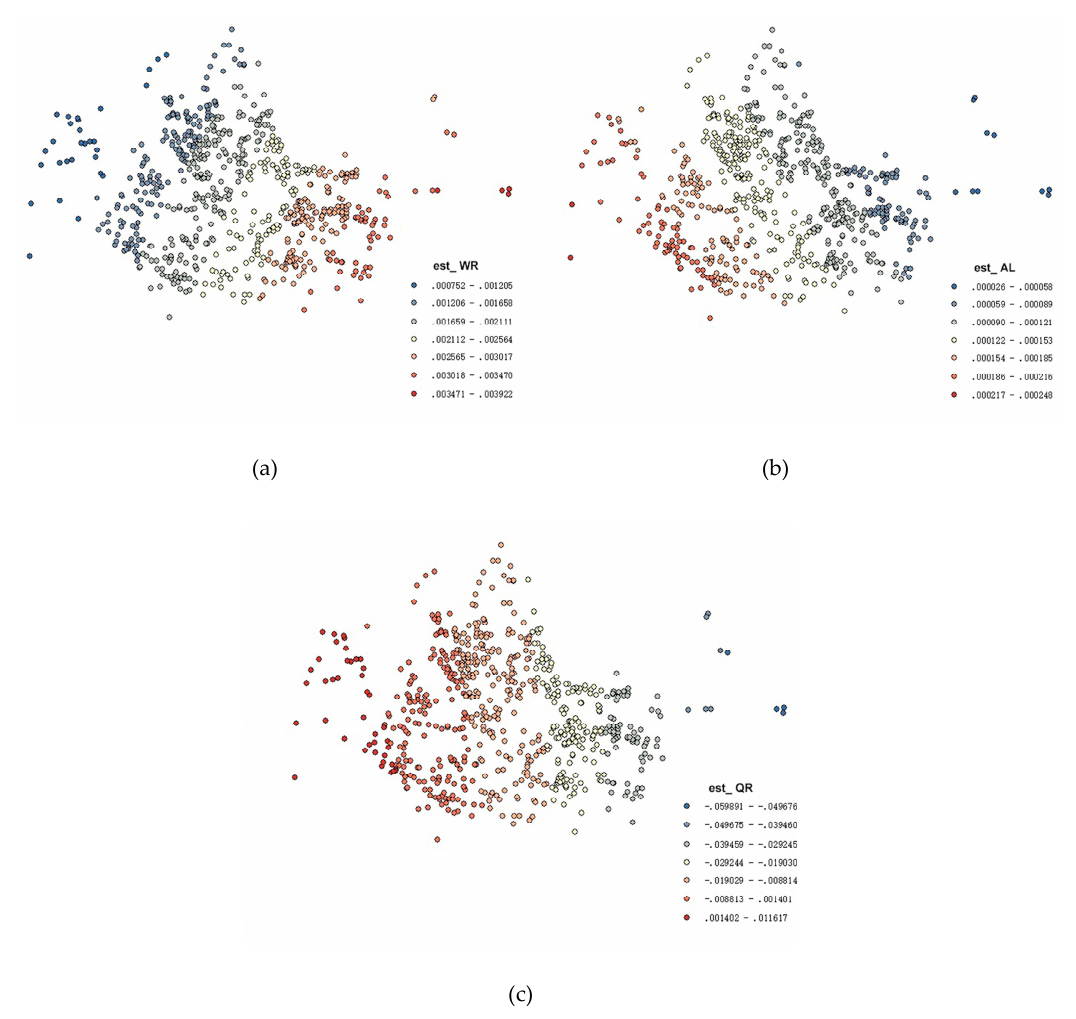
Figure 8. Regression coefficient distribution of river width ( a ), lake area ( b ) and river water quality ( c ).